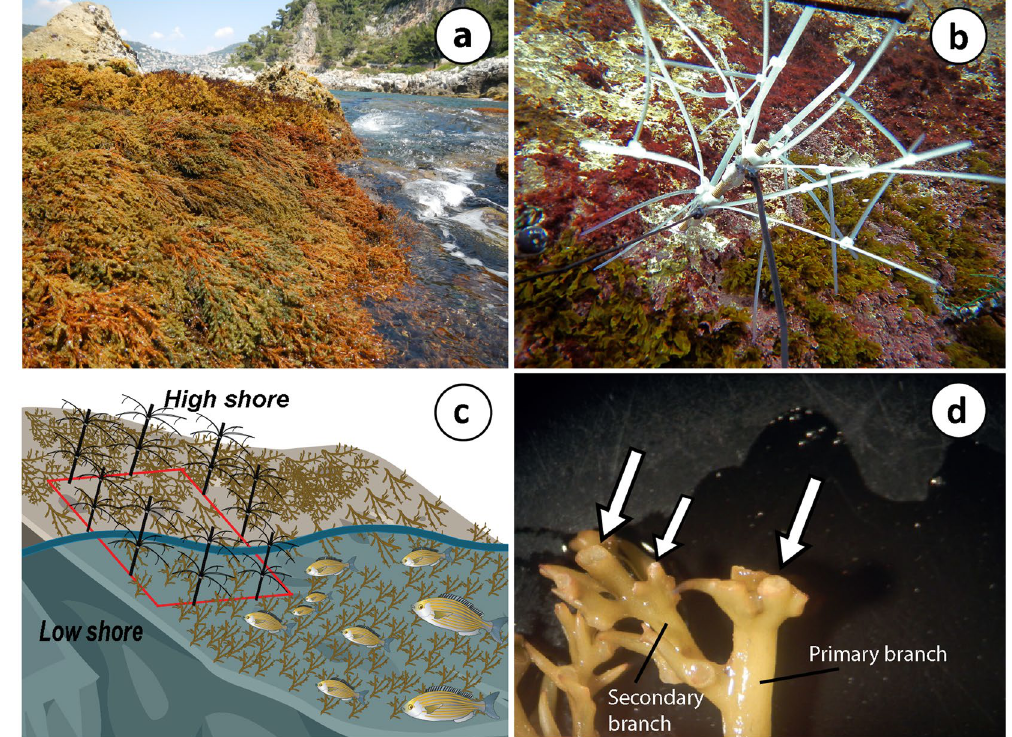
Figure 2. ( a ) Cystoseira amentacea belts in the infralittoral fringe; ( b ) the deterrent device DeFish used to deter fish grazing on C. amentacea ; ( c ) schematic representation of the two vertical zones of the infralittoral fringe characterized by long and short C. amentacea branches; a protected plot with DeFish is also shown on the shore; ( d ) detail of the primary and secondary C. amentacea branches with fish bites (white arrows). Photos by Bartolini F. Figure 2c attributions: salema and Cystoseira illustrations (Tracey Saxby, Integration and Application Network, University of Maryland Center for Environmental Science